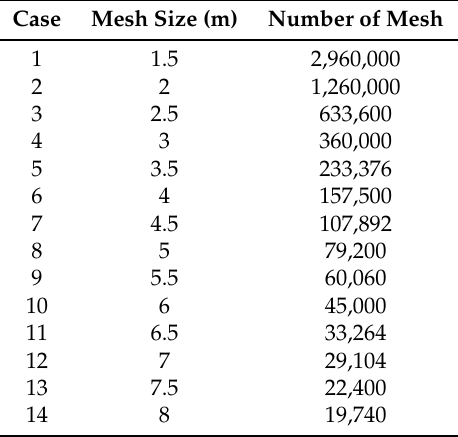
Table 4. Mesh size and total mesh